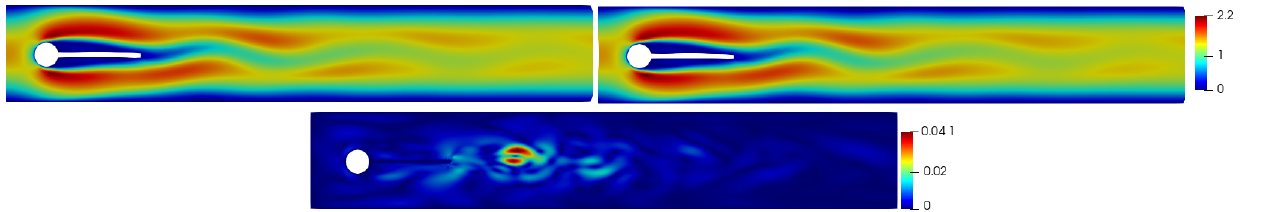
Figure 11. Fluid velocity at time t = 0.9 s: the FE solution ( top left ) and the reduced order solution ( top right ). Bottom: approximation error | u f , h − u f , N | . N u = 42 basis functions were used for the fluid